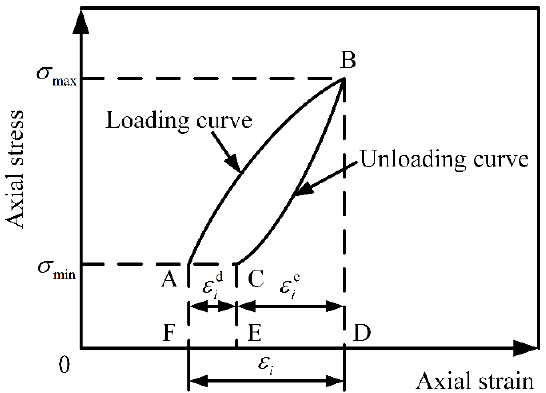
Figure 7. The relationship between the strain energy and dissipated energy.